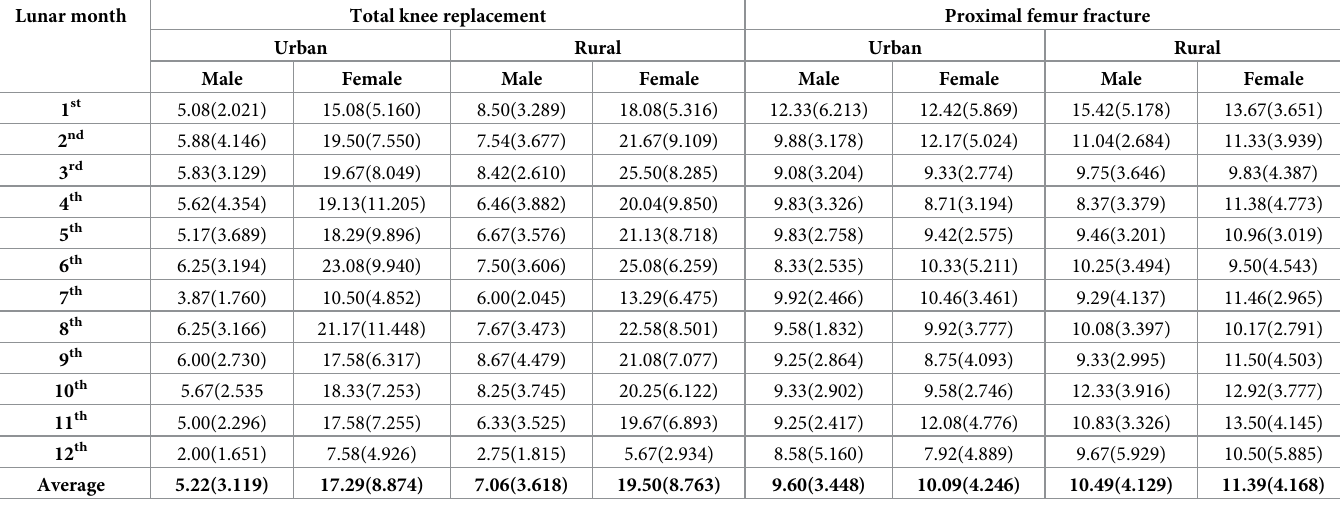
All values are reported as mean (standard deviation).